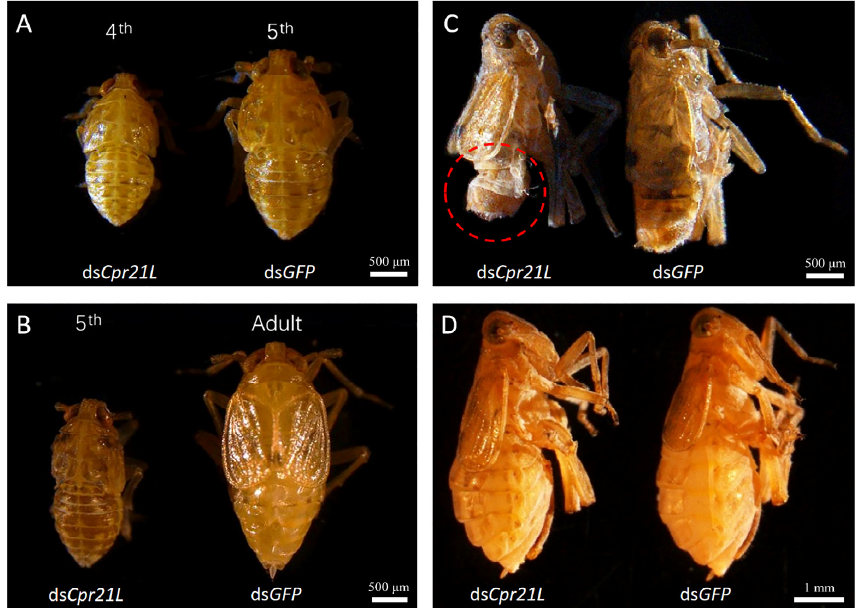
Figure 5. Effects of Cpr21L knockdown on the development of BPHs. ( A , B ) Effect of RNAi against Cpr21L on the growth and development of BPH nymphs. ( C ) Effect of RNAi of Cpr21L on the male adult. ( D ) Effect of RNAi of Cpr21L on the female adult. Scale bars: ( A ), ( B ), and ( C ) = 500 μ m; ( D ) = 1 mm.